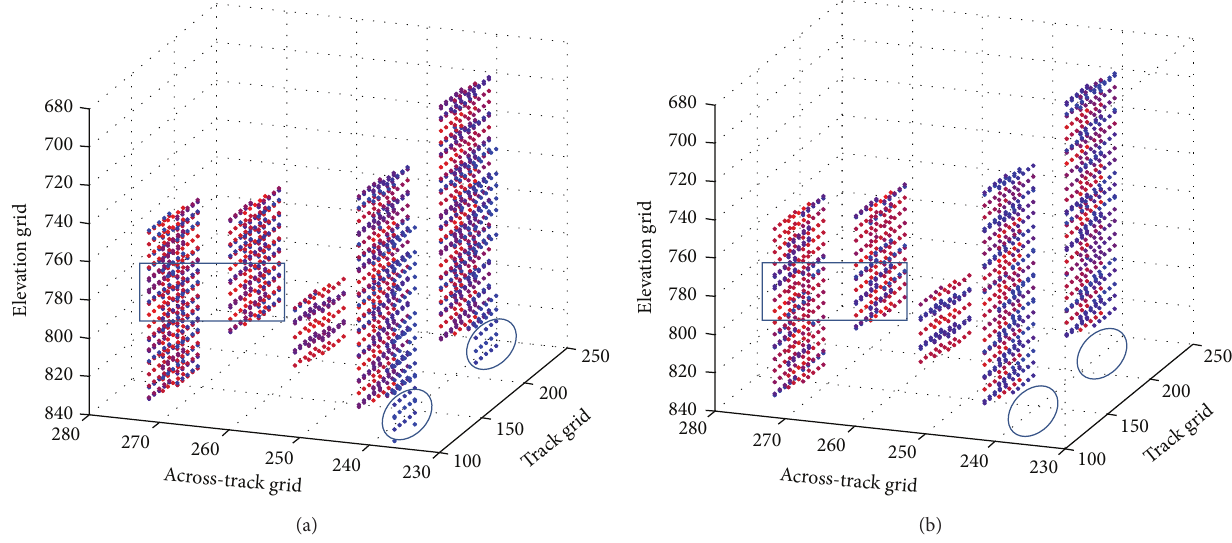
Figure 8: The imaging results with (a) the SC-MOCO method and (b) the proposed JMC-MOCO method.